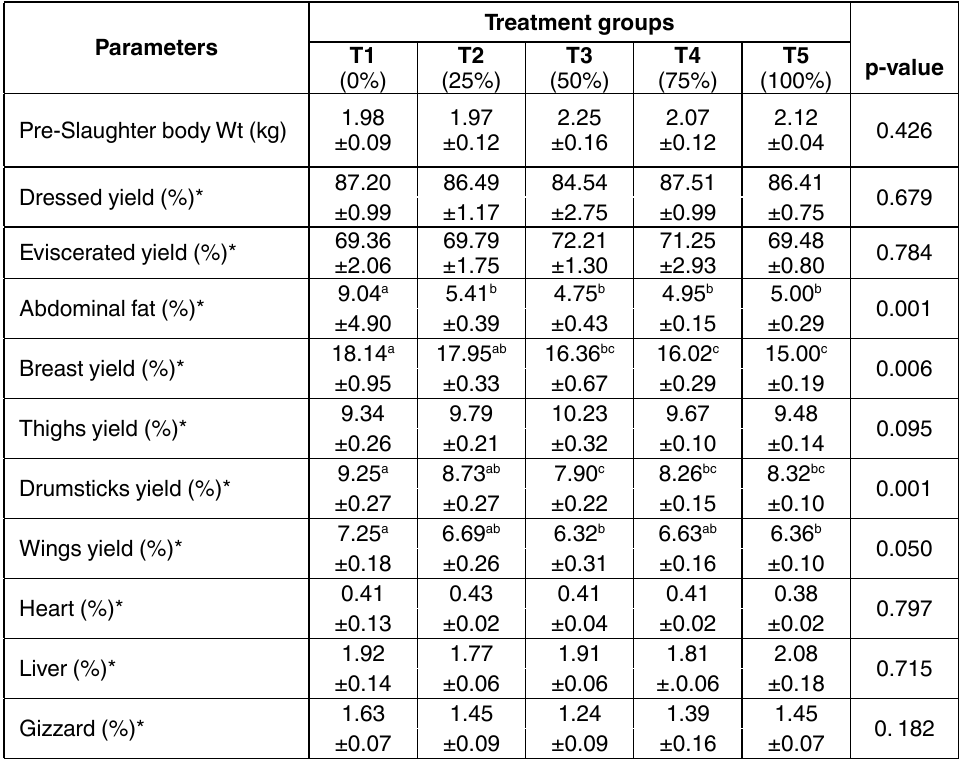
Table 4. Mean (±SE) values of carcass characteristics in Gramasree hens fed with BSF larvae as protein replacer at different levels at 48 weeks of